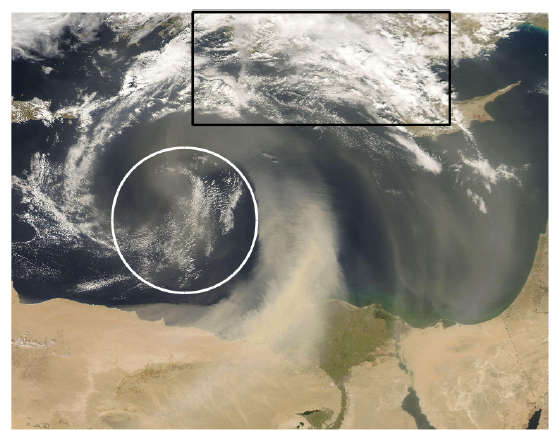
Fig. 1. MODIS visible image, 25 September